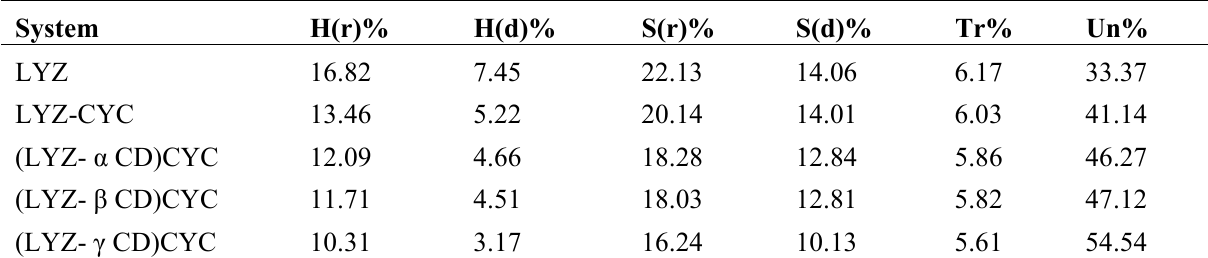
(H(r) regular alpha-helix, H(d) disordered alpha-helix, S(r) regular beta-sheet, S(d) disordered beta-sheet, Tr Turn, Un unordered